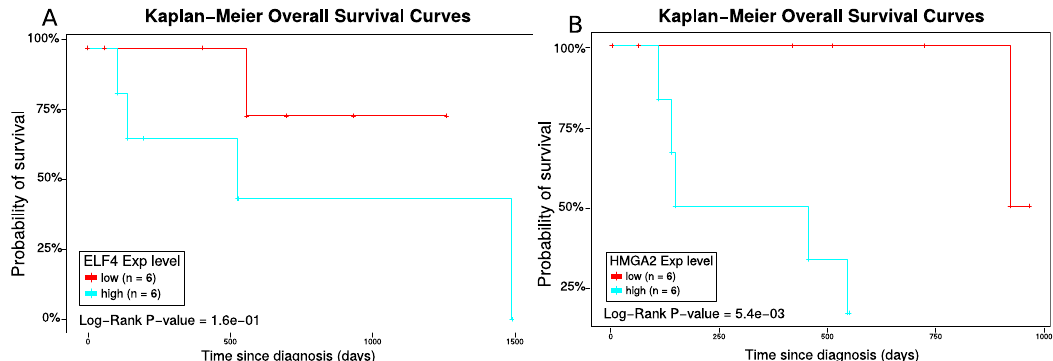
Figure 20. A ) Survival plot for the 30% patients with high expression and low expression of ELF4 TF. B ) Survival plot for the 30% patients with high expression and low expression of HGMA2